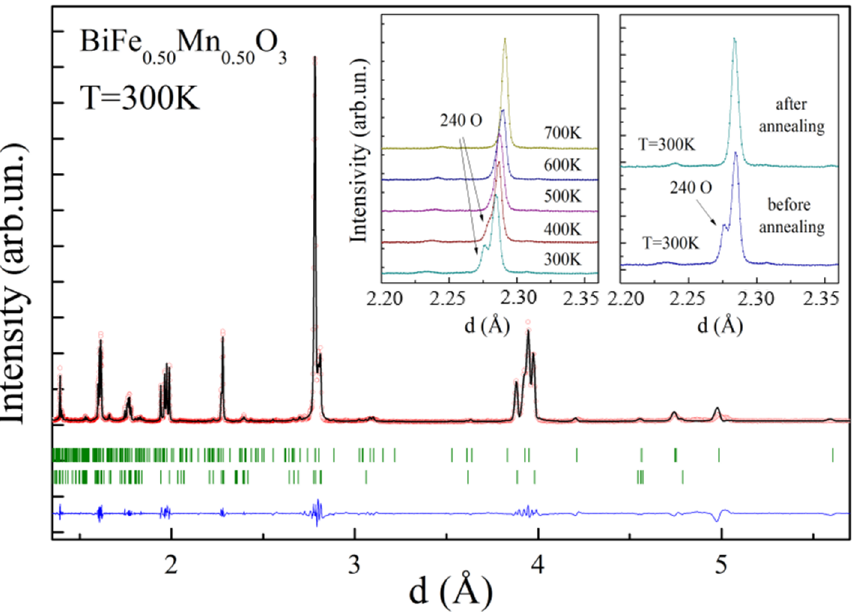
Figure 2. Room-temperature synchrotron diffraction pattern of BiMn 0.5 Fe 0.5 O 3 with a two-phase structural state (upper vertical dashes denote Bragg positions specific for the orthorhombic phase, bottom vertical dashes denote the monoclinic phase). The left inset shows temperature-dependent changes of the reflections attributed to the dominant orthorhombic phase, and the right inset shows specific reflections before and after annealing of the compound at T ~ 700 K (O— Pnma phase). The compound with x = 0.7 is single phasic with a monoclinic structure, and at room